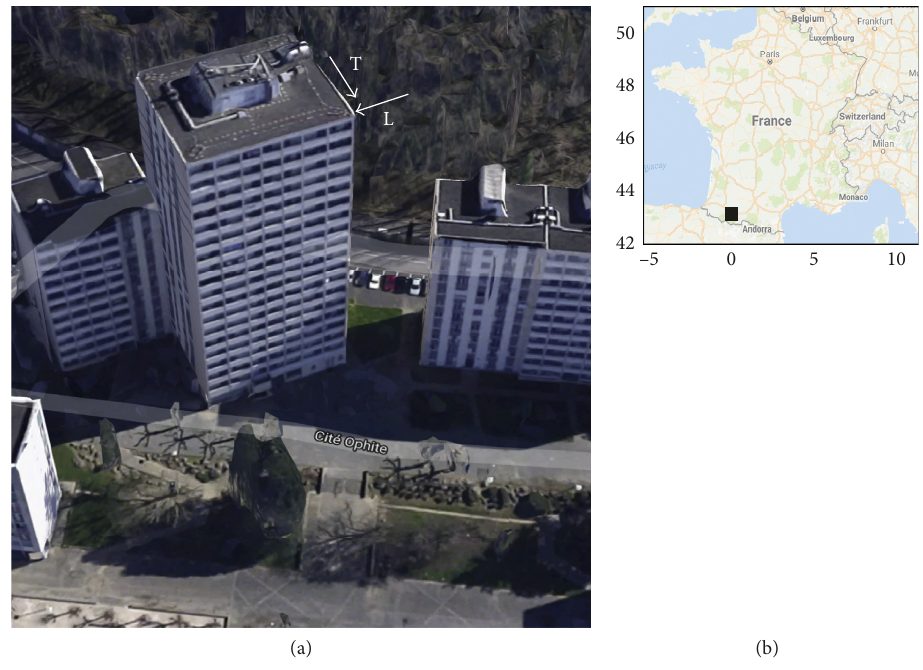
Figure 1: Outside view of (a) the Ophite tower building and (b) its location in